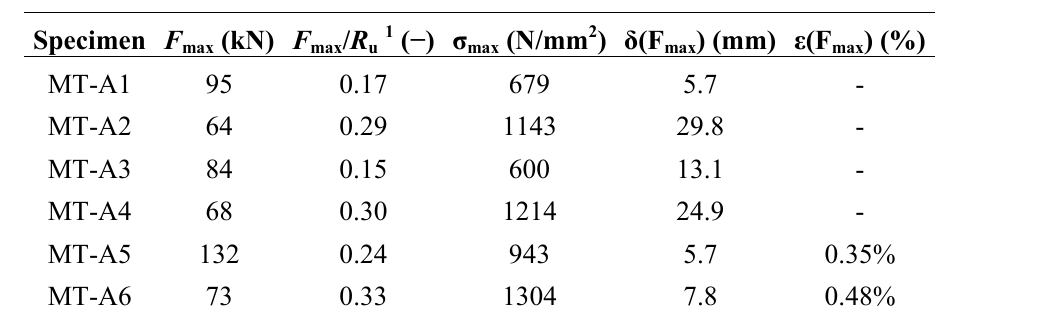
Table 5. Test results of Series